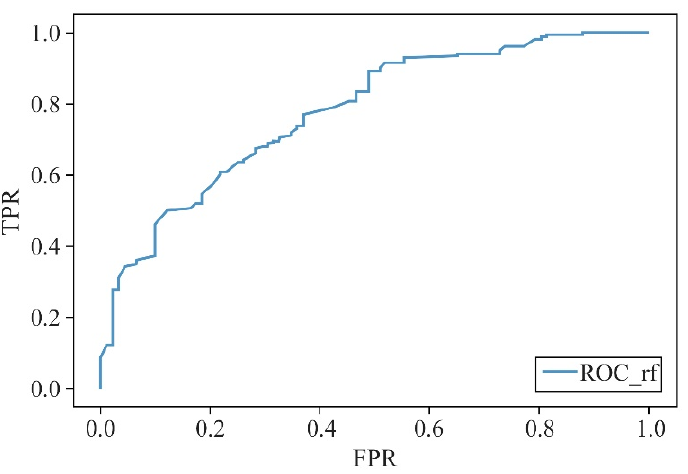
Figure 8. ROC curve for the random forest model with 17 indicators (“TPR”: true positive rate; “FPR”: false positive rate).